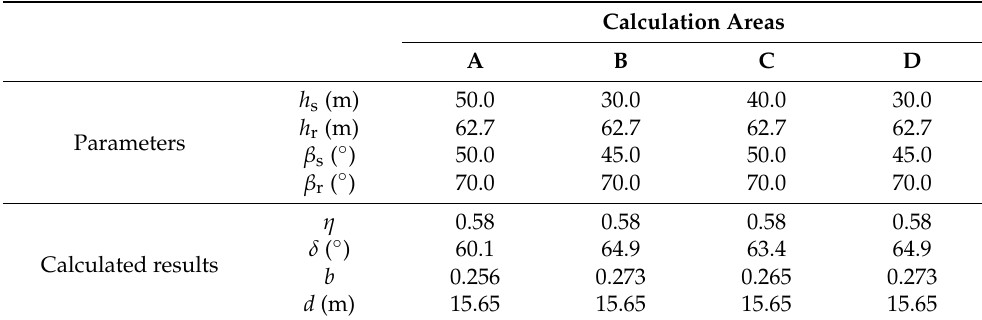
Table 7. Calculated probability integration parameters of the individual areas.